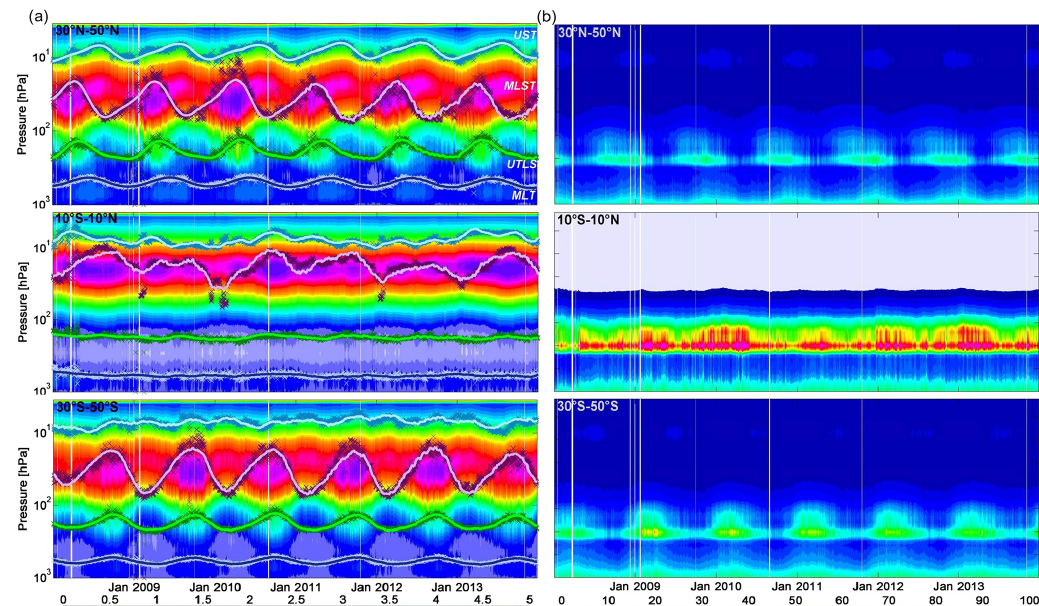
Figure 4. (a) Daily IASI O 3 profiles (1 × 10 12 moleculescm − 3 ) for the period 2008–2013 and over the range of the retrieved profiles as a function of time and altitude, in three latitude bands: 30–50 ◦ N (top), 10 ◦ S–10 ◦ N (middle) and 30–50 ◦ S (bottom). Superimposed daily IASI O 3 partial columns (scatters) and the associated fits (solid lines) from the multivariate regressions for the MLT (ground–300hPa), UTLS (300–150hPa), MLST (150–25hPa) and UST (above 25hPa) layers. The IASI measurements and the fits have been scaled for clarity. (b) Estimated total retrieval errors (%) associated with daily IASI O 3